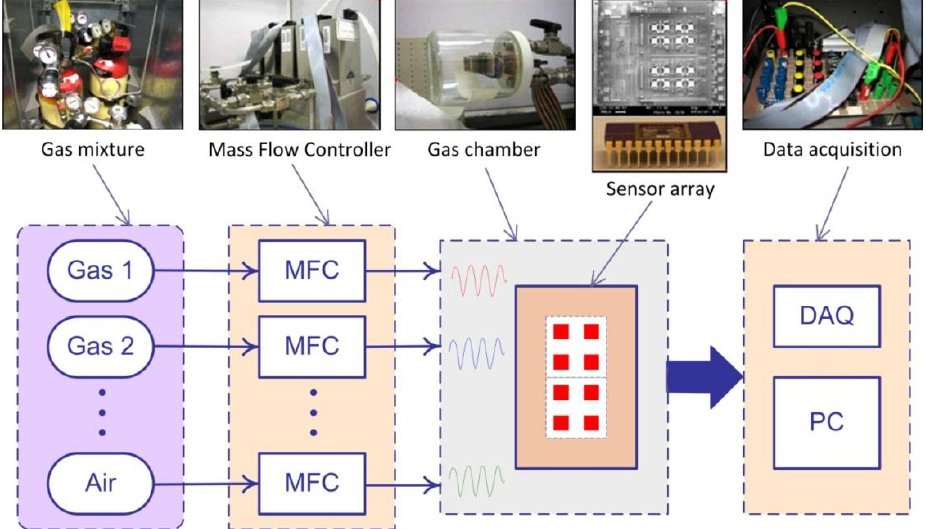
Figure 3. Experimental setup used to characterize the sensors. V stands for Valve, MFC stands for mass flow controller, and the DAQ is the data acquisition board used to control the setup and to acquire the signals from the sensor array